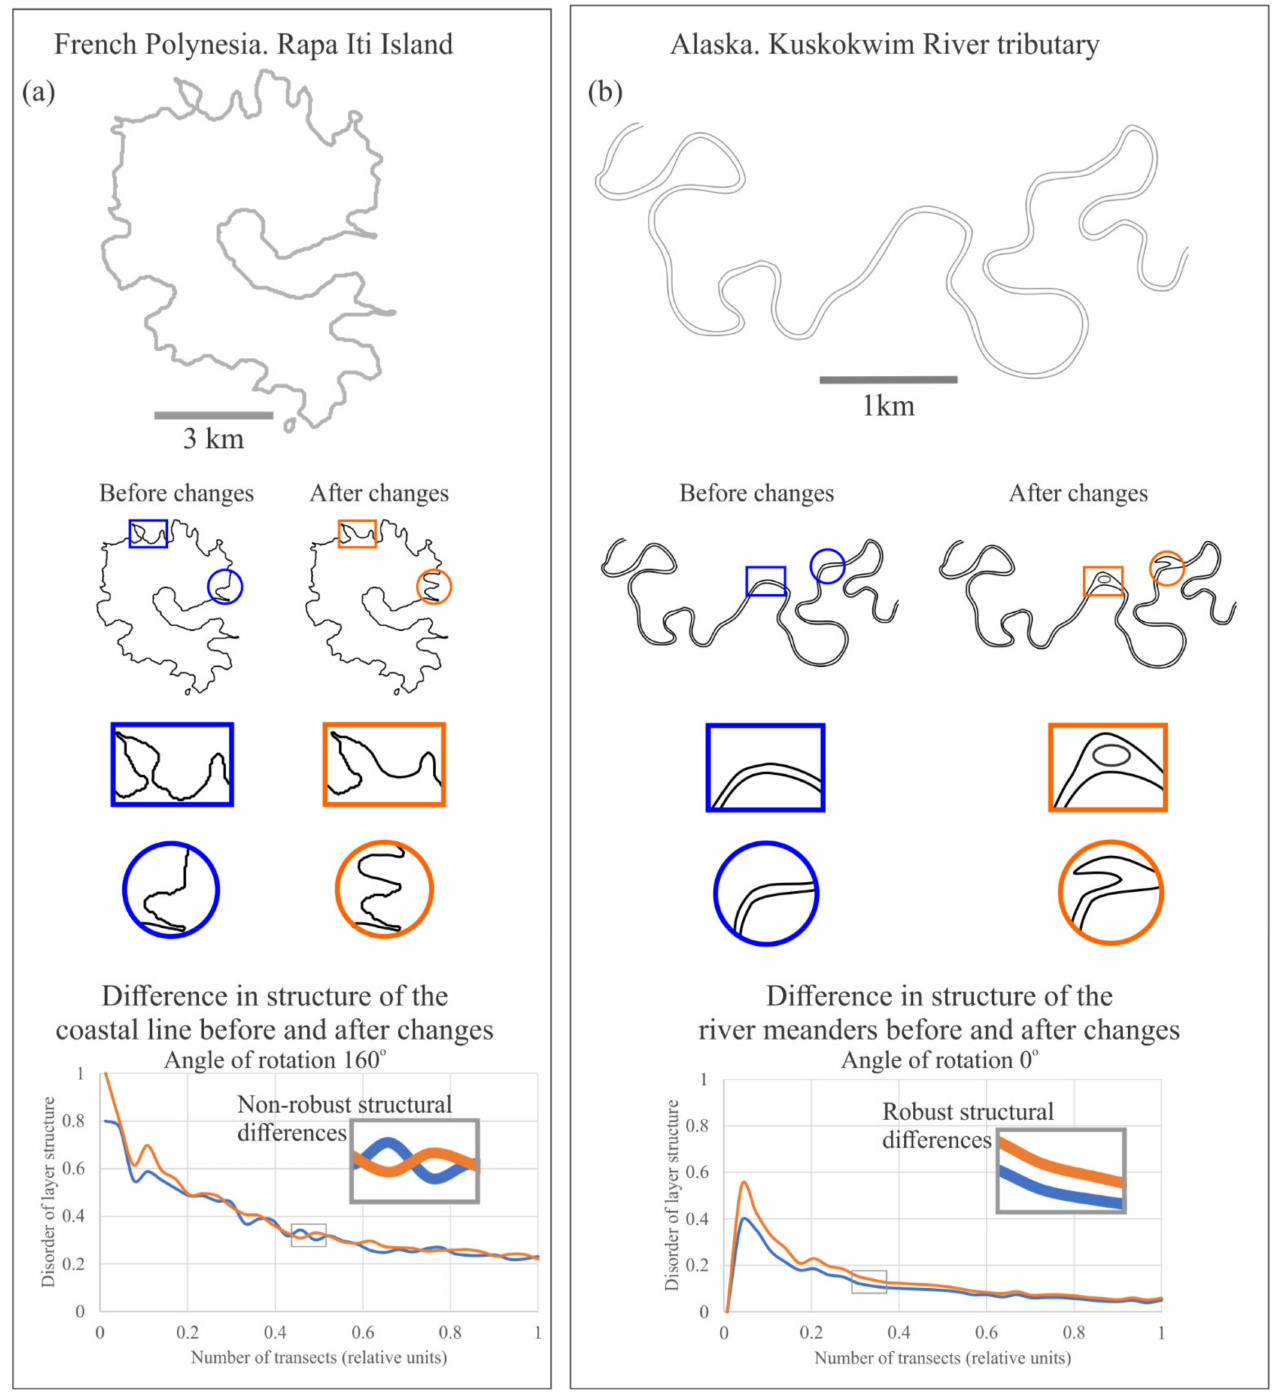
Figure 12. Discriminating non-robust and robust morphological differences. ( a ) Characteristic of non-robust differences. ( b ) Characteristic of robust differences. Credits: Rapa Iti Island—Wiki [38]. Kuskokwim River tributary—NOAA